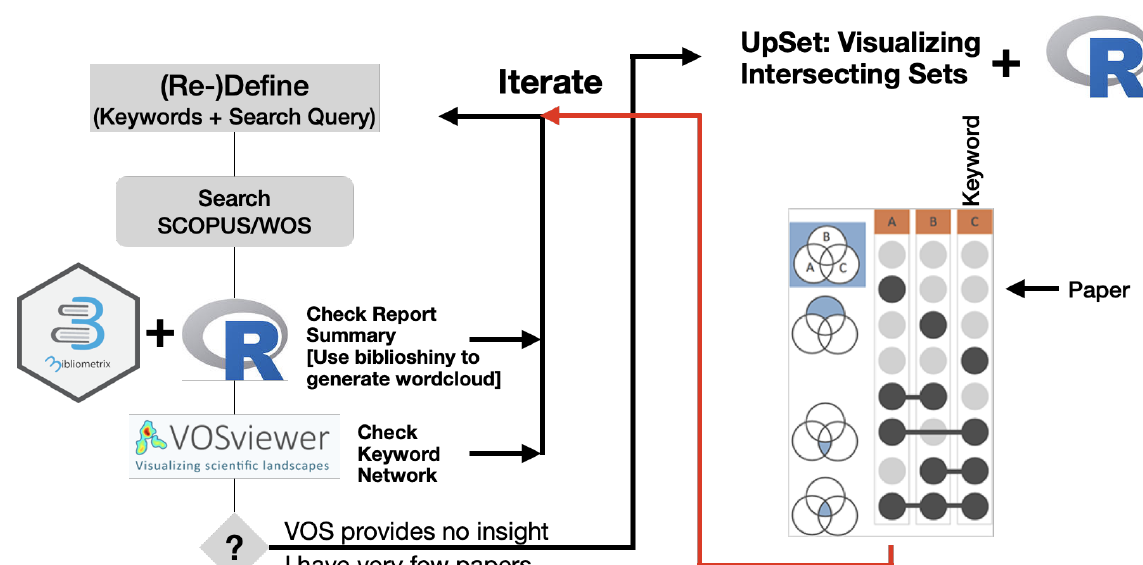
Fig. 1. The keyword exploration process (uses logos for the different tools and the picture extracted from the UPSet website that was adapted to explain the intersecting sets of keyword /